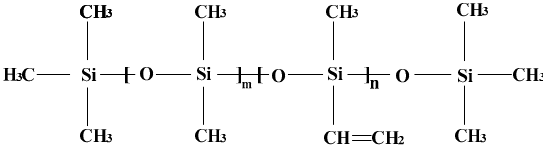
Figure 1. Molecular structure of polymethylvinyl siloxane.